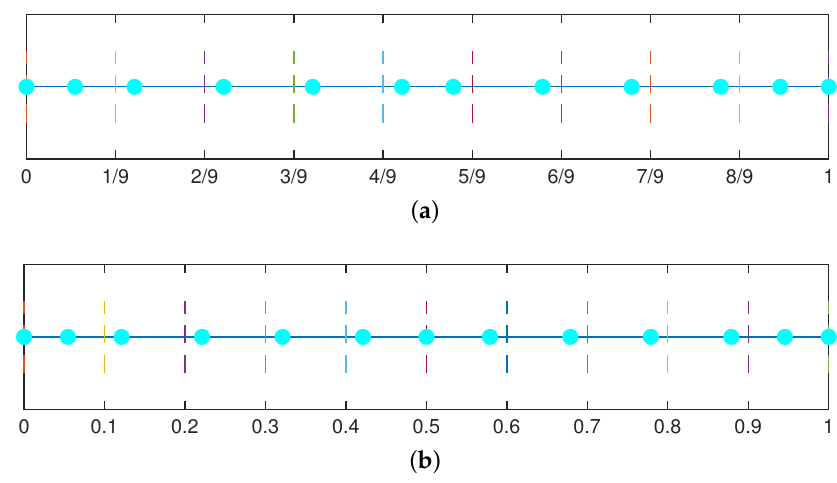
Figure 6. CG points ( p = 3). ( a ) Odd number of elements. ( b ) Even number of elements.